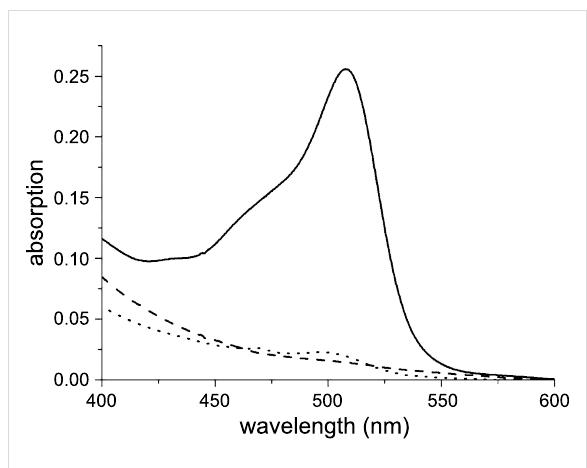
Figure 4: UV spectra of TPX 8c and 8d functionalized with fluorescein revealing the efficiency of the 1,3-dipolar cycloaddition reactions on modified TPX membranes. Continuous line: 8d ; dotted line: 8c ; dashed line: substrate for Huisgen-type “click” reaction 7a .